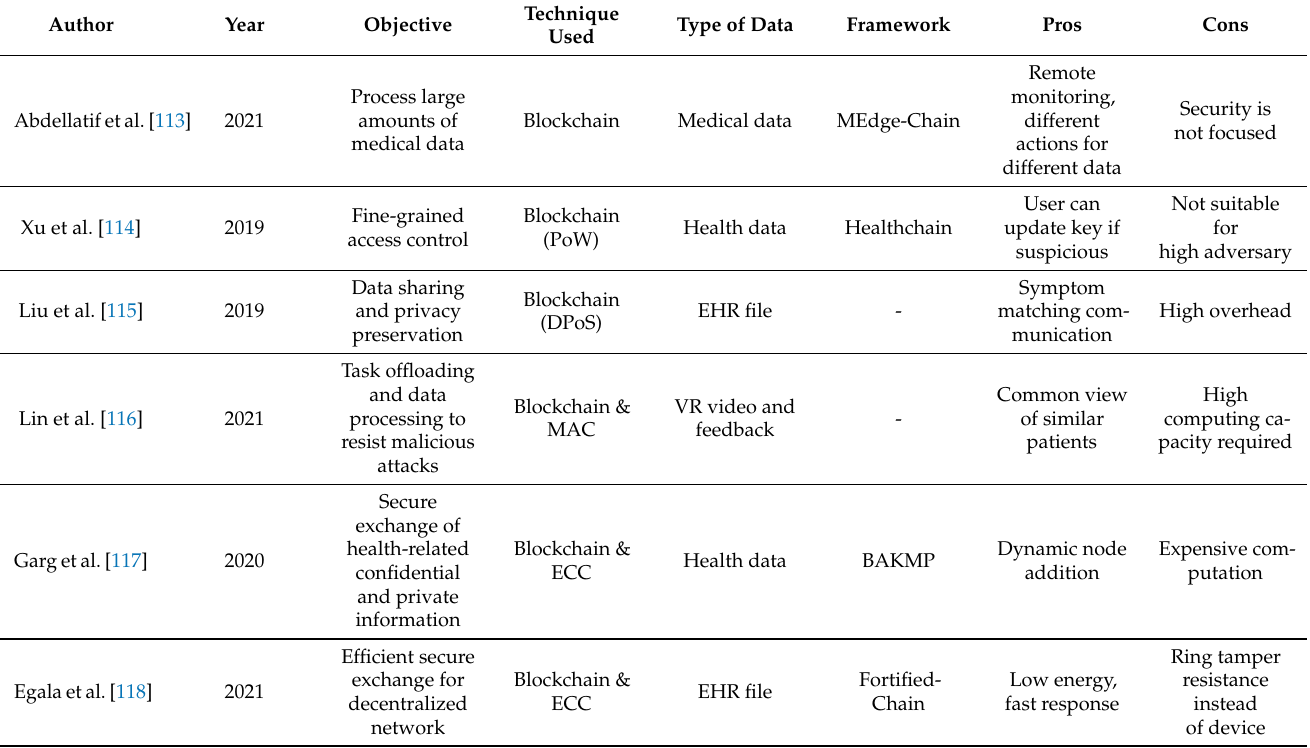
Table 3. Comparative analysis of decentralized IoMT security schemes (blockchain